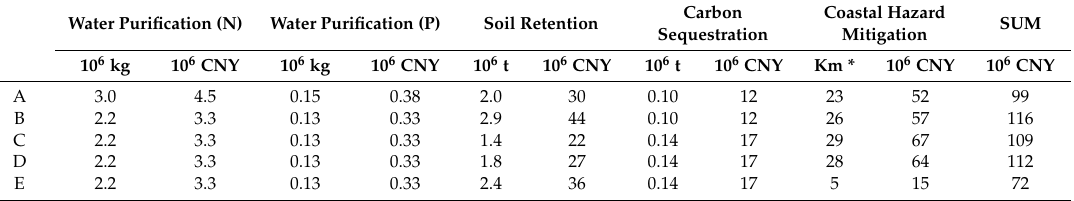
Carbon Coastal Hazard SUM Sequestration Mitigation